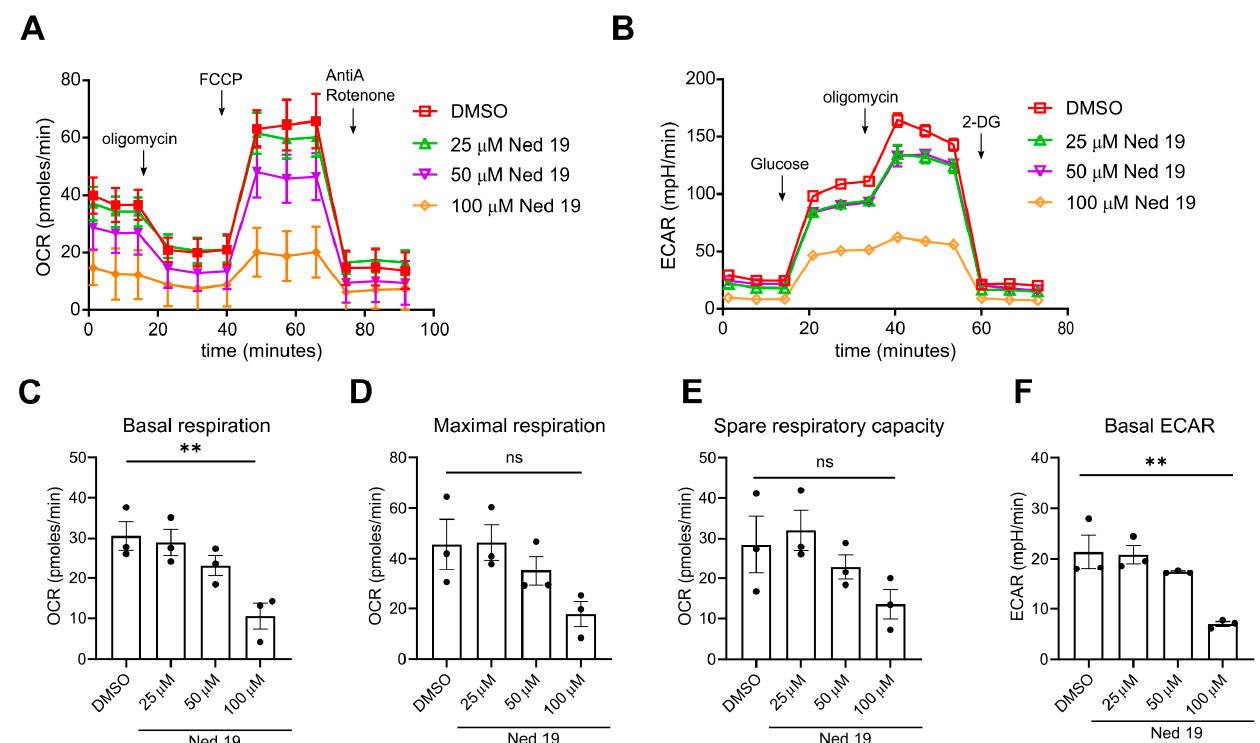
Figure 2. NAADP inhibition by means of trans-Ned 19 limits metabolic upregulation upon TCR stimulation in naïve CD4 + T cells. The naive CD4 + T cells were freshly isolated from triple reporter IL-17A eGFP × IFN- γ Katushka × Foxp3 RFP mice. The cells were incubated with increasing concentrations of trans-Ned 19 for 1 h, stimulated with plate bound anti-CD3 and soluble anti-CD28 mAbs, and cultured for 16 h in the presence of increasing concentrations of trans-Ned 19. ( A ) Representative oxygen consumption rate (OCR) measured by extracellular flux analysis. FCCP, carbonyl cyanide-p-trifluoromethoxyphenylhydrazone; AntiA, Rotenone + anti-mycin A. (B) Extracellular acidification rate (ECAR) measured by extracellular flux analysis. 2-DG—2-deoxyglucose. ( C ) Summary statistics of basal OCR. ( D ) Summary statistics of maximum OCR. ( E ) Summary statistics of spare respiratory capacity ( F ) Summary statistics of basal ECAR. Presented data are mean ± SEM. p -values were calculated with ordinary one-way ANOVA with Dunnett’s multiple comparison test. ** p < 0.01.